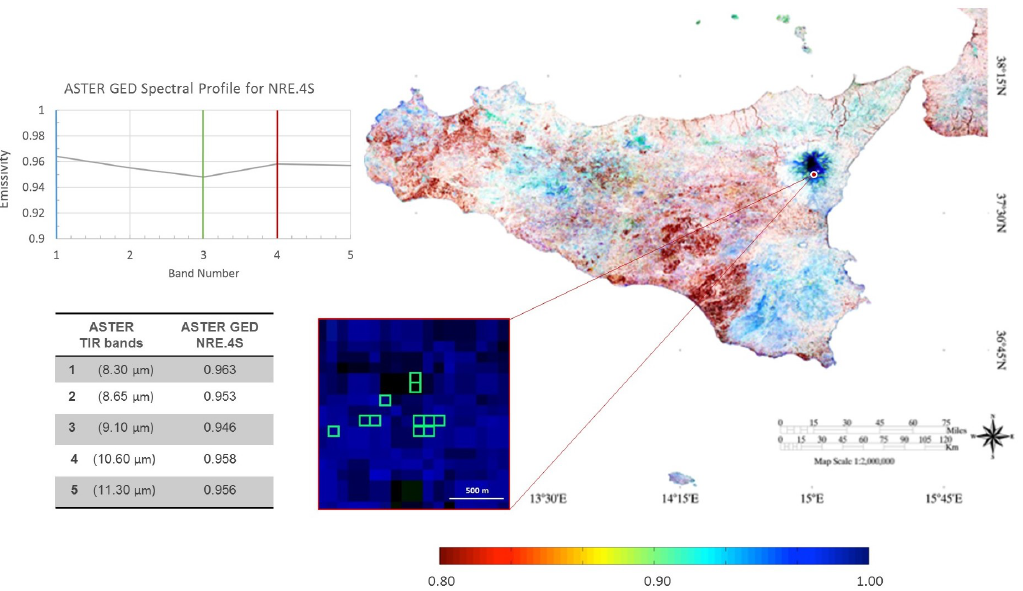
Figure 4. (Map) ASTER Global Emissivity Database (ASTER GED) over Sicily, Italy at 100-m pixel resolution at 10.60 µ m and 4-3-1 band red–green–blue (RGB) view. The color ramp indicates the mean emissivity values (0.8–1.0). Inset shows samples’ pixel locations for NRE.4S. Emissivity spectral profile